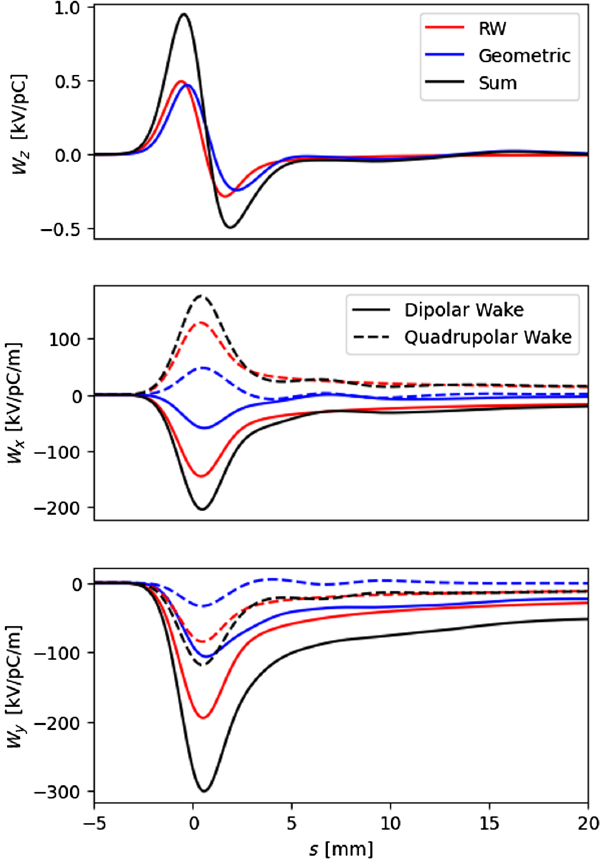
FIG. 3. Longitudinal (top), dipolar (solid), and quadrupolar (dashed) short range horizontal (middle) and vertical (bottom) wake potentials for the EBS for σ z ¼ 1